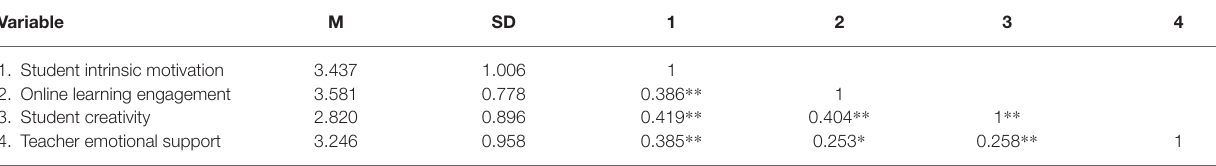
TABLE 2 | Descriptive statistics and correlations.